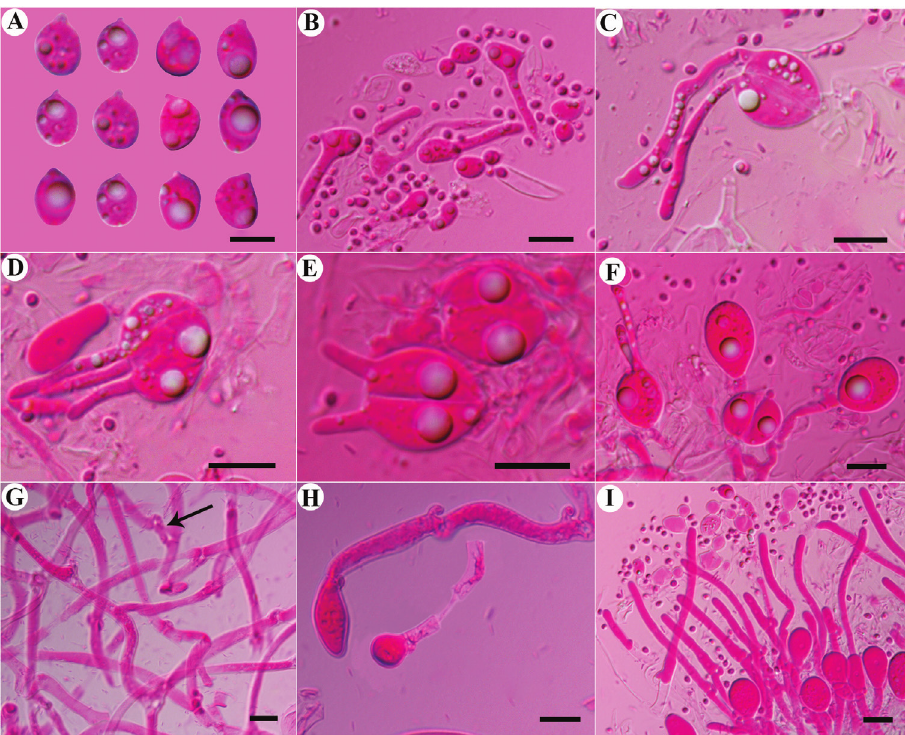
Figure 8. Microscopic structures of Tremella “neofibulifera” (Wu 248) A basidiospores B germination tubes of basidiospores and secondary spores C–E basidia at different stages F probasidia G hyphae with clamp connections and clamp complexes H vesicles I parallel hyphidia in hymenium. Scale bars: 10 µm ( A–I